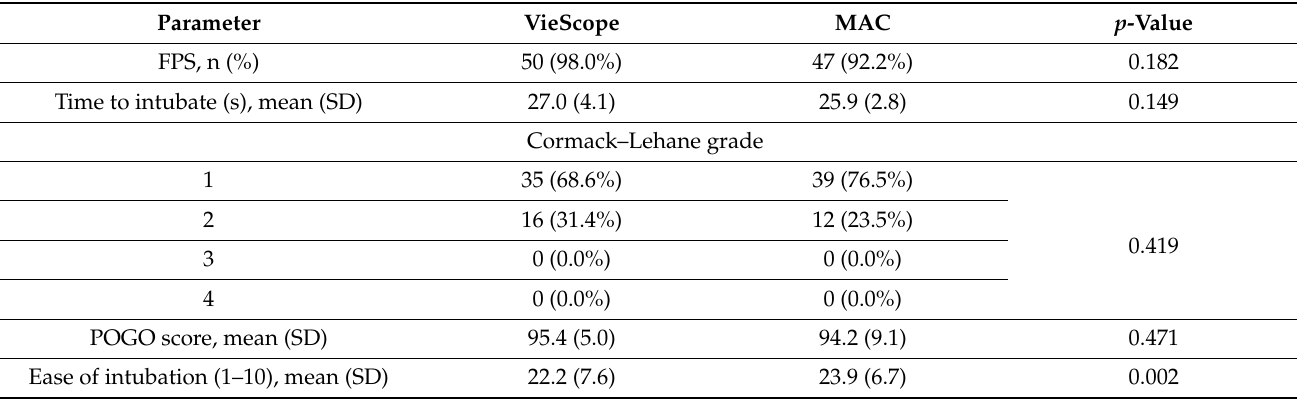
Table 1. Intubation without personal protective equipment for aerosol-generating procedures (PPE- AGP) scenario.